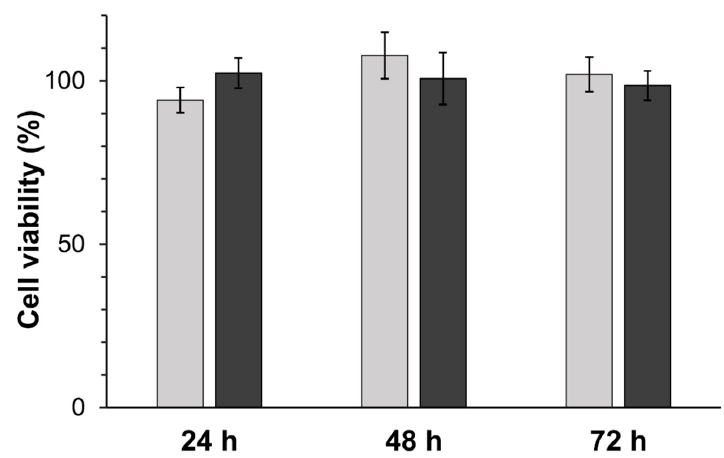
Figure 7. Cell viability of HEK 293 T cells after 24-, 48-, and 72-h growth periods in the presence of two different concentrations of Tm AFP. Light grey signifies 50 µg/mL of Tm AFP, and dark grey 100 µg/mL of Tm AFP. Cell viability was assessed through MTT reduction, and viability is shown as a percentage of control cells. Cell viability experiments were performed using four different preparations of Tm AFP and error bars represent ± standard error of the mean (SEM).